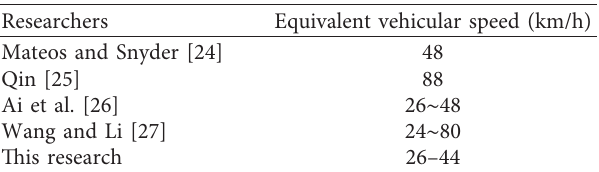
Table 9: The comparisons between the equivalent speeds of FWD loading from different